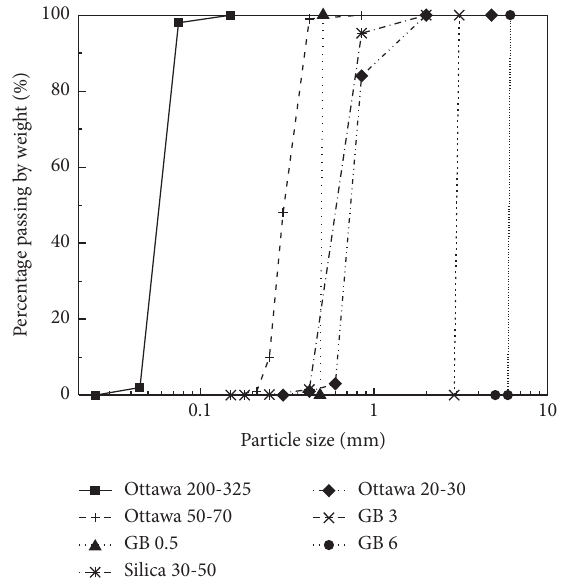
Figure 2: Grain size distribution of glass beads, Ottawa sands, and silica